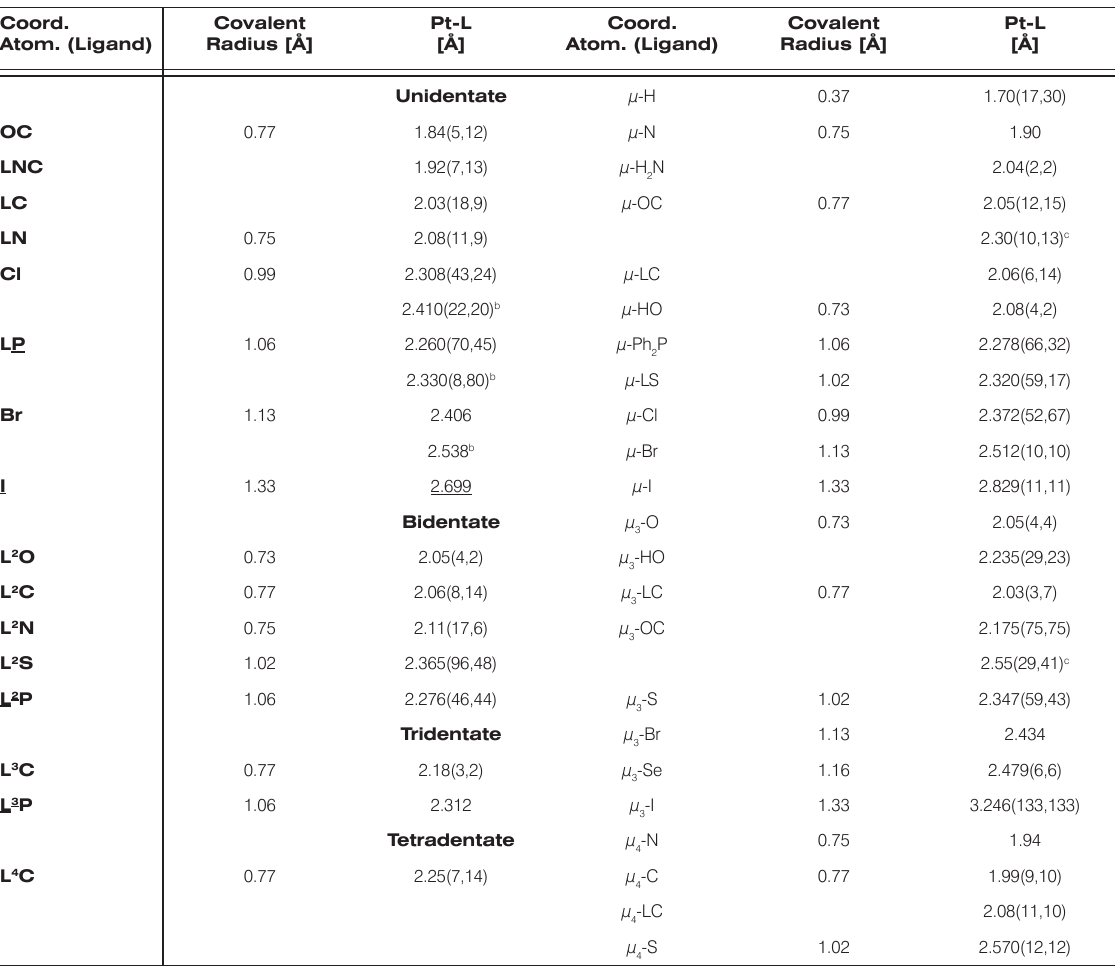
Table 5. Summary of the Mean Pt-L (atom) Bond Distancis for Heterotetranuclear Clusters a . Coord. Atom.